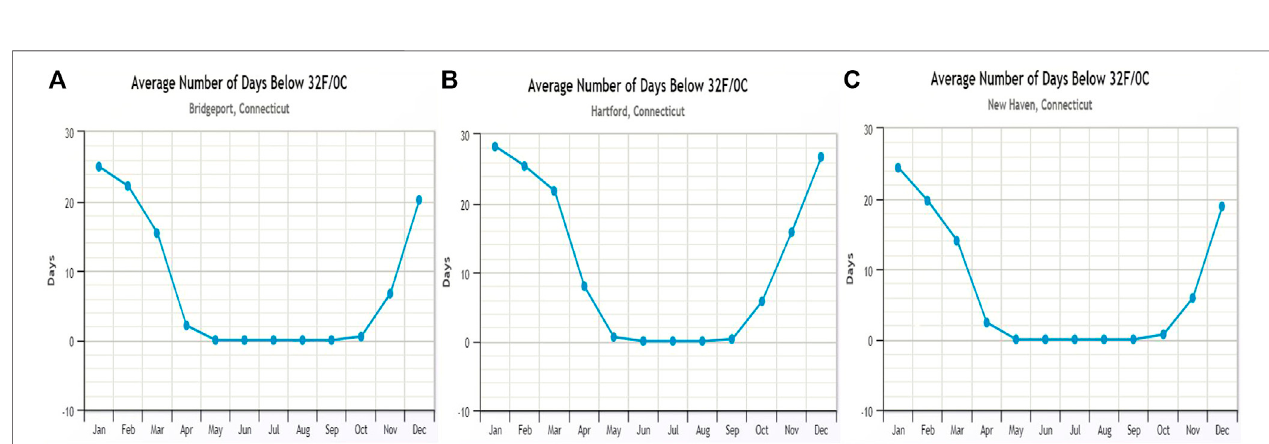
FIGURE 5 | Historical data showing the average number of days below 0 ° C (monthly) in the counties [Fair fi eld (Bridgeport) — (A) , Hartford — (B) , and New Haven — (C) ].